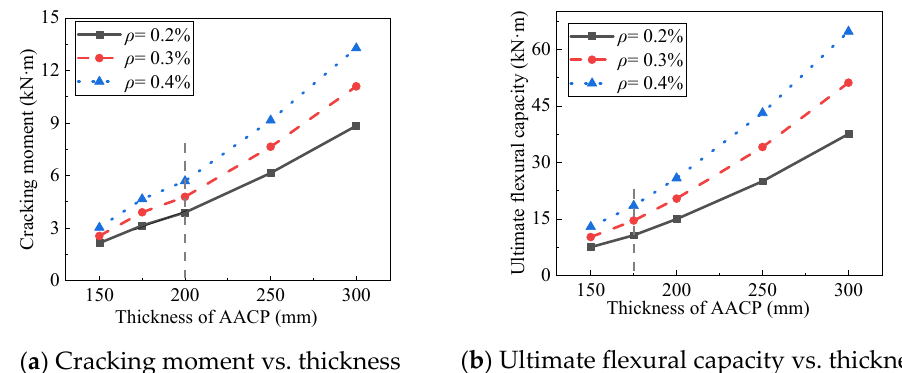
Figure 18. Effect of the reinforcement ratio.